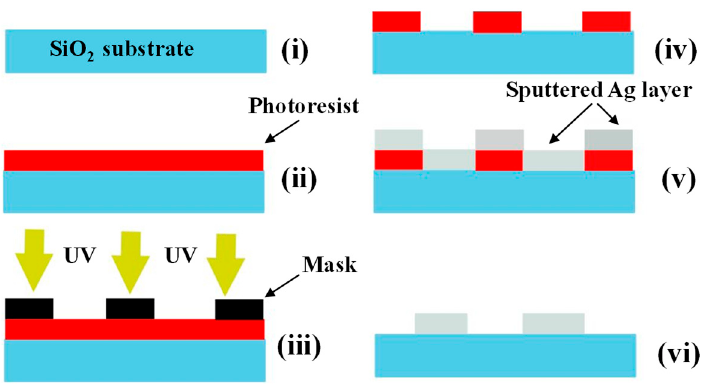
Figure 2. Ag IDEs photolithography process. ( i ) substrate ( ii ) photoresist on substrate ( iii ) UV illumination ( iv ) generated pattern ( v ) sputtered Ag layer ( vi ) final electrodes on substrate.